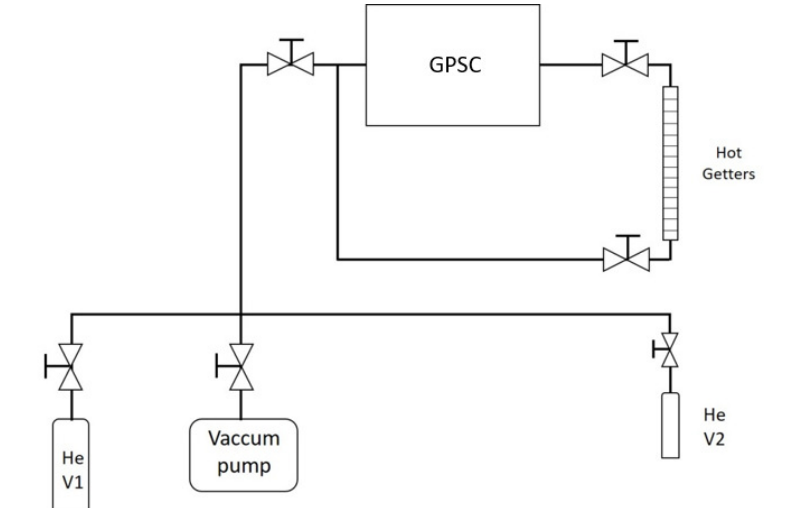
Figure 3 . Layout of the experimental setup, including the GPSC, the gas circulation and purifying system with SAES St-707 getters and the two helium volumes for implementing the